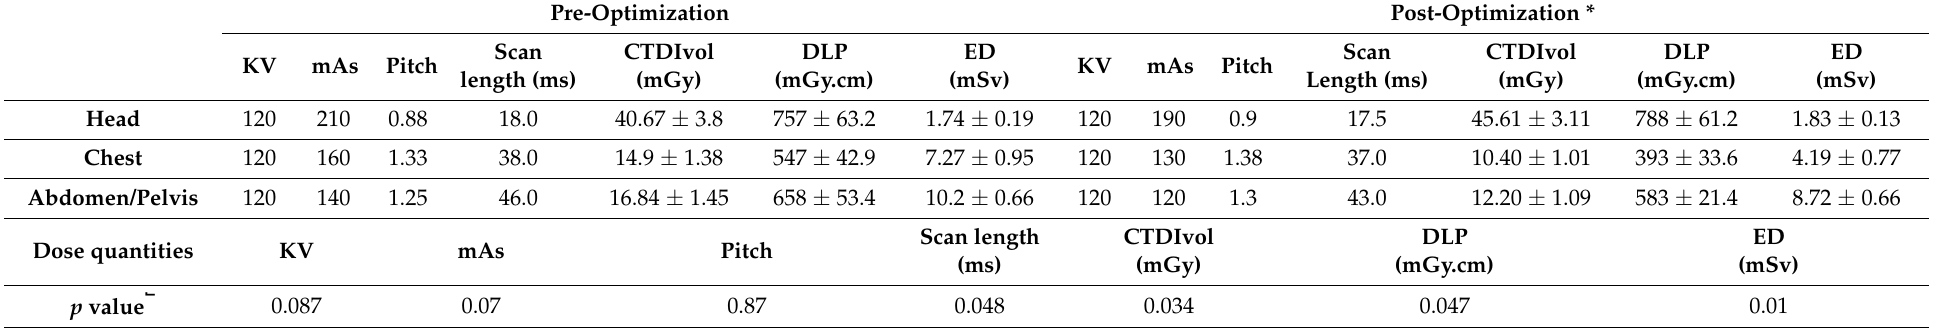
Table 1. Mean dose parameters ± Standard deviation before and after optimization.